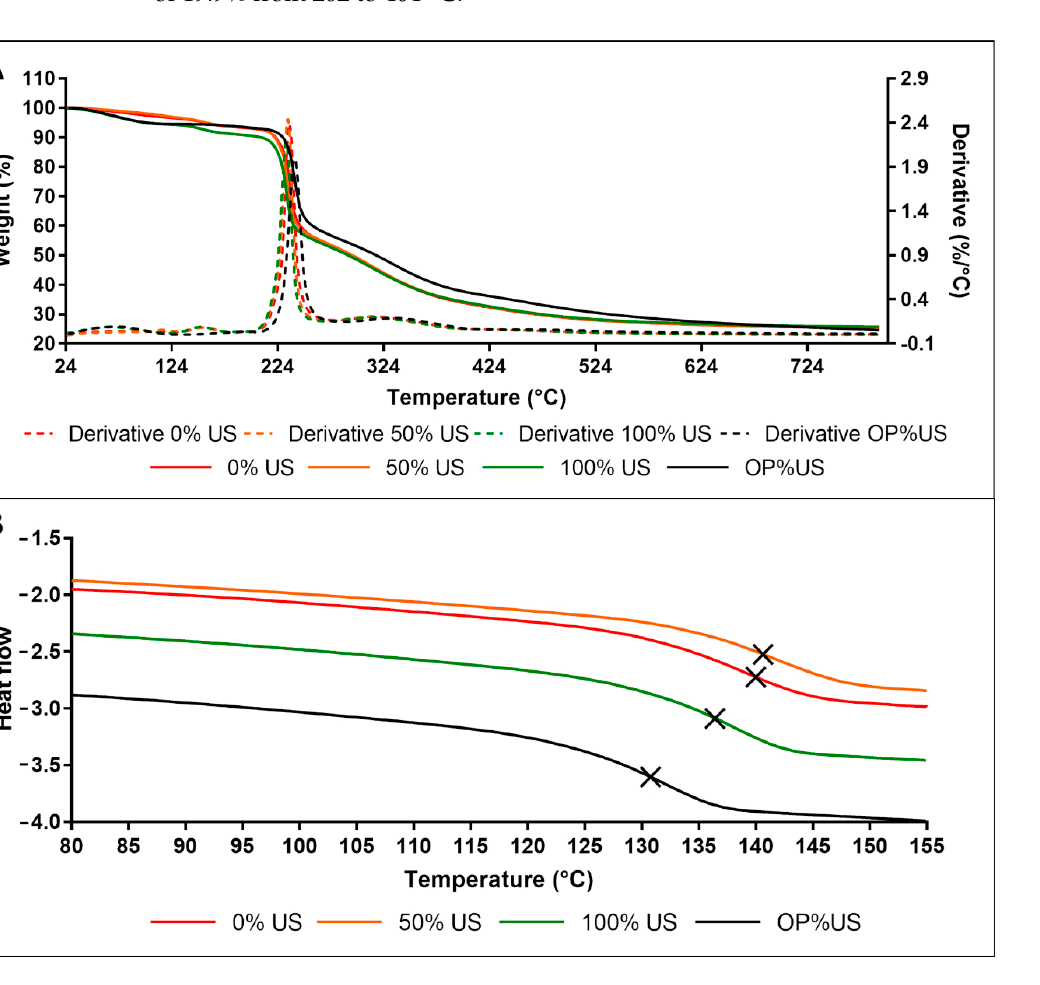
Figure 4. TGA curves ( A ), second heating scan thermograms of DSC ( B ) of 0, 50, 100% US and